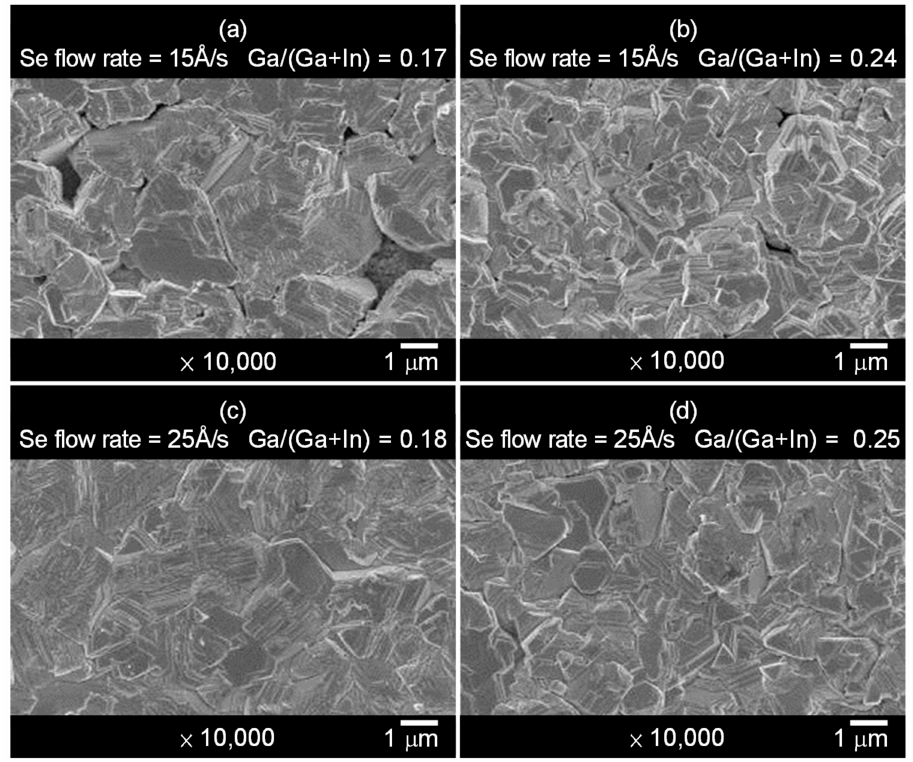
Figure 2. SEM micrographs of surface morphologies of CIGS films with ( a ) low and ( b ) high Ga content selenized at low Se flow rate (15 Å/s), and of CIGS films ( c ) low and ( d ) high Ga content selenized at high Se flow rate (25 Å/s).